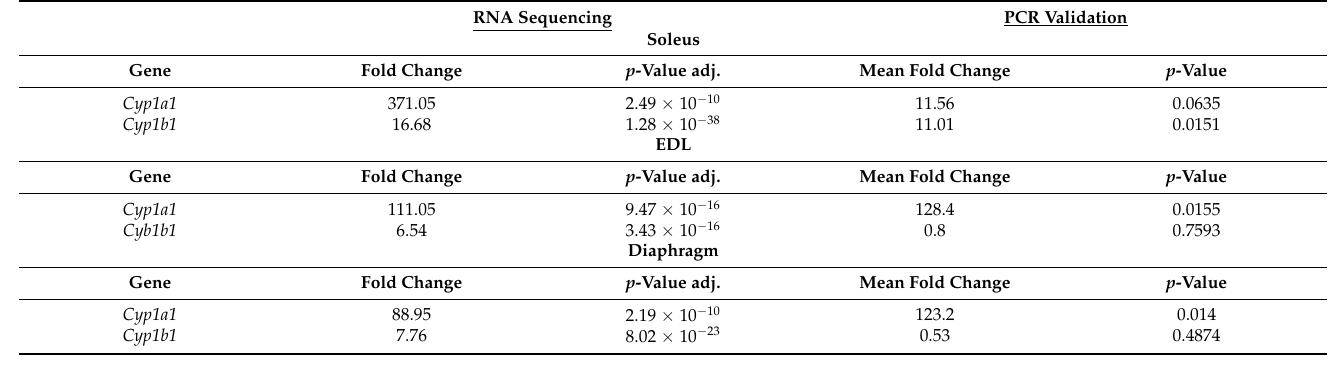
Table 1. Validation of RNA sequencing. Top differentially expressed genes in the soleus, EDL, and diaphragm of SU/Hx vs. control rats are validated by qPCR in an independent cohort of animals ( n = 5 per group).